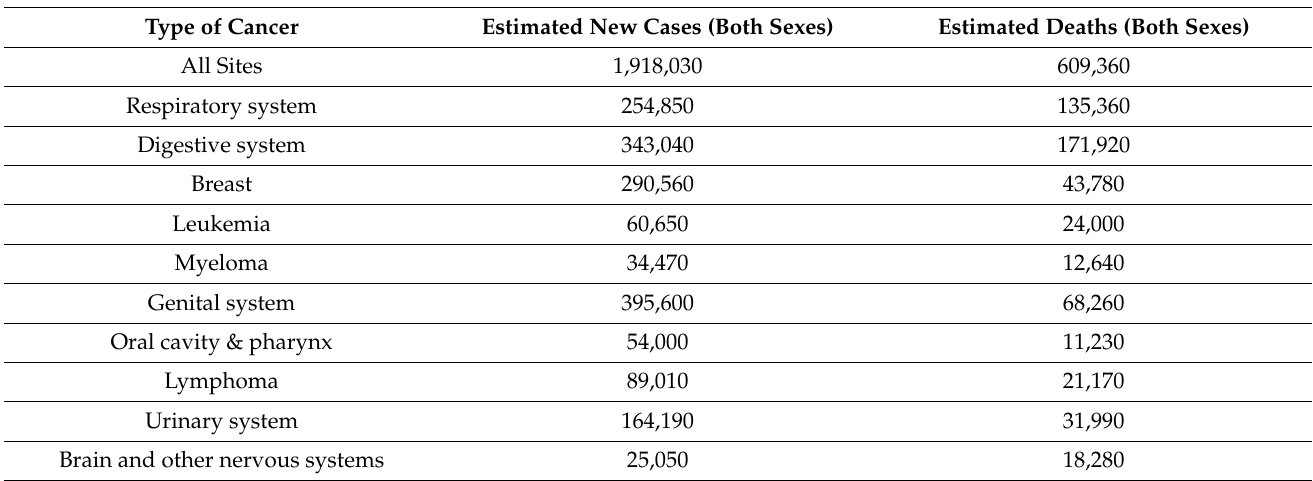
Table 2. Estimated new cancer cases reported and deaths occurring due to various types of cancer in the US in the current